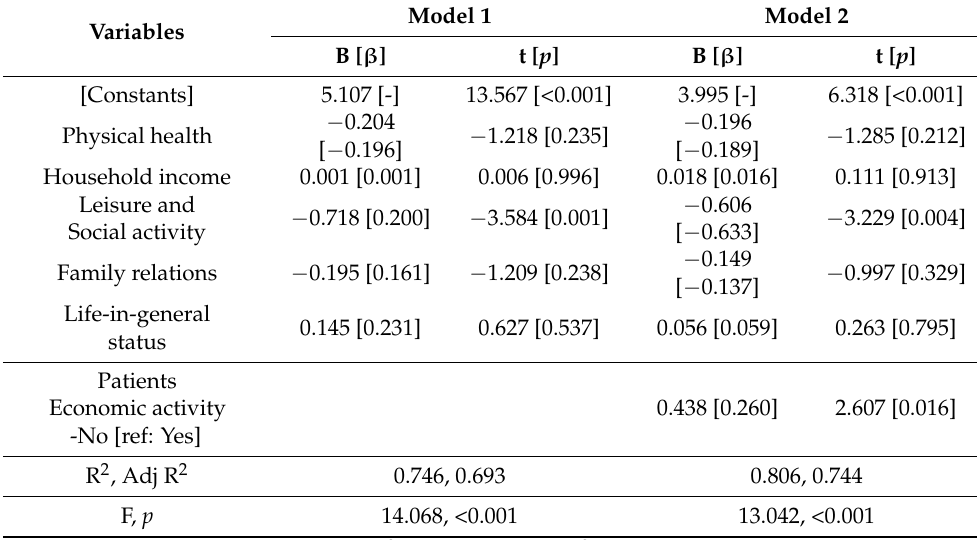
Table 5. Factor association of depression in